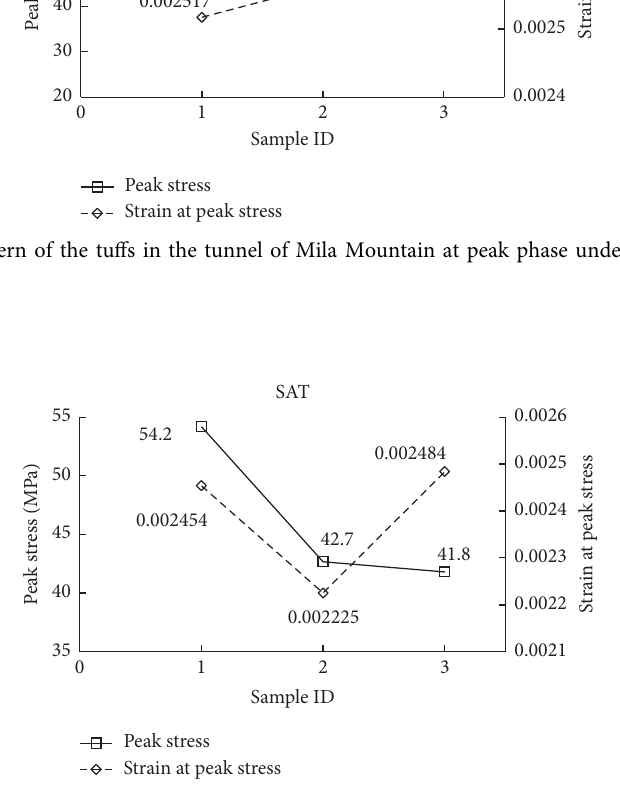
Figure 12: Pattern of the tuffs in the tunnel of Mila Mountain at peak phase under saturated